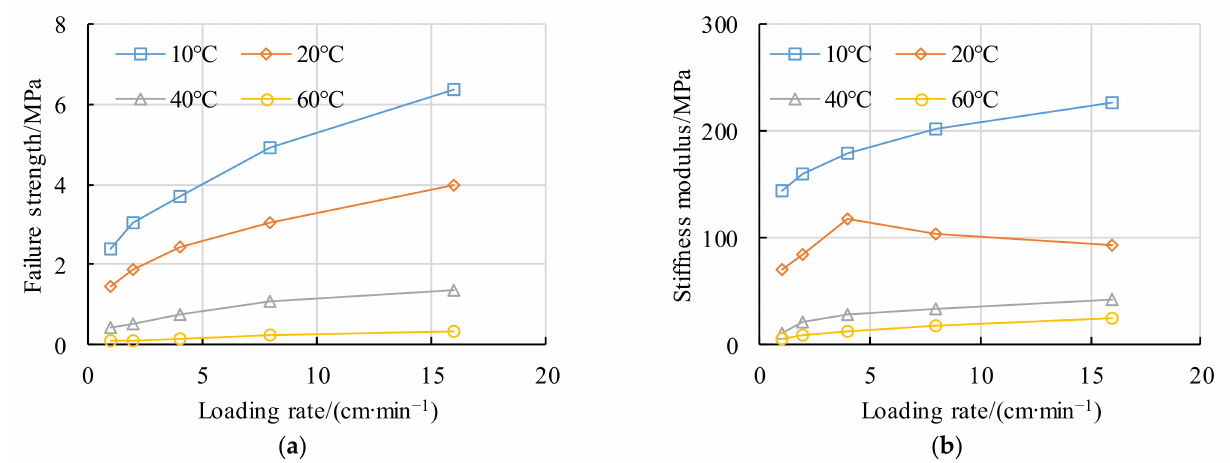
Figure 7. Effect of loading rate and temperature on tensile results of 20% CRA mixture: ( a ) failure strength; ( b ) stiffness